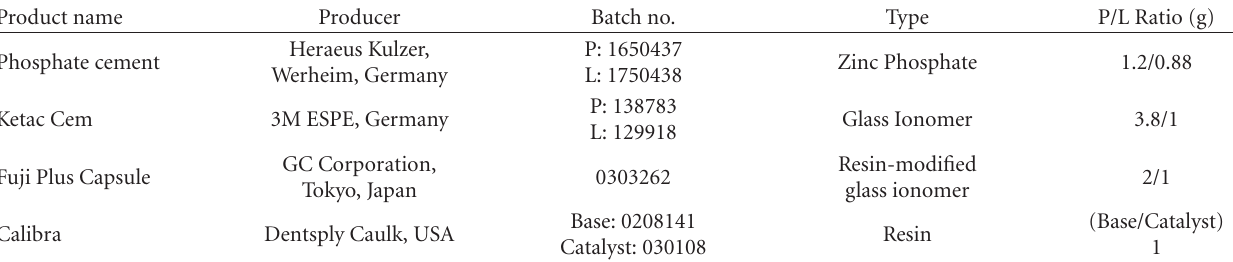
Table 2: Luting cements used in